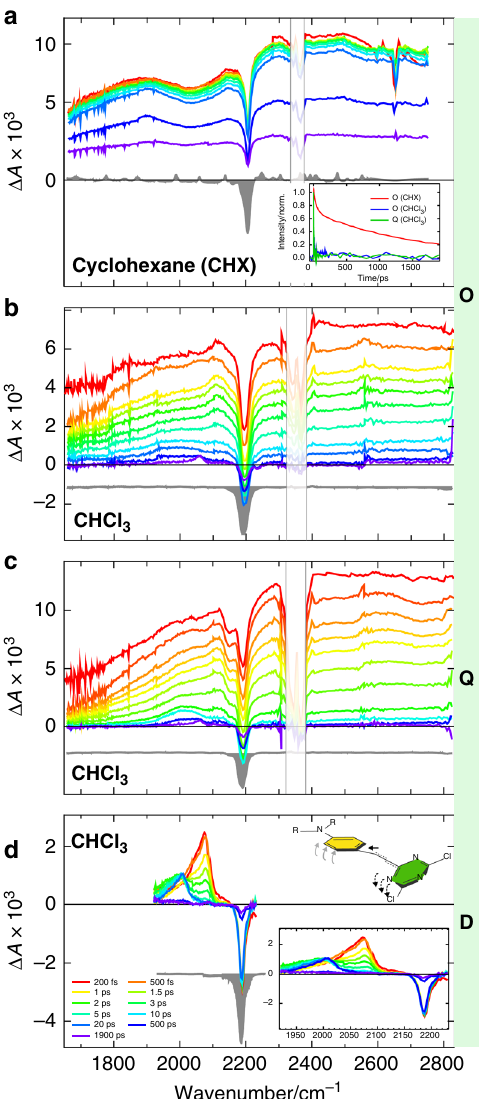
Fig. 2 TRIR spectral evolution of the triazine-based systems upon S 1 ← S 0 excitation. a O in the non-polar cyclohexane. b O in medium-polar chloroform and c Q in medium-polar chloroform. The inset in a shows the time dependence of the integrated 2400 – 2800 cm − 1 intensity for a – c . donor is in yellow). The inset in d zooms into the spectral region with non- zero signal for D . The gray-shaded spectra are the negative stationary IR spectra (offset for clarity). The region near 2350 cm − 1 is shaded to cover interferences caused by atmospheric CO 2 .